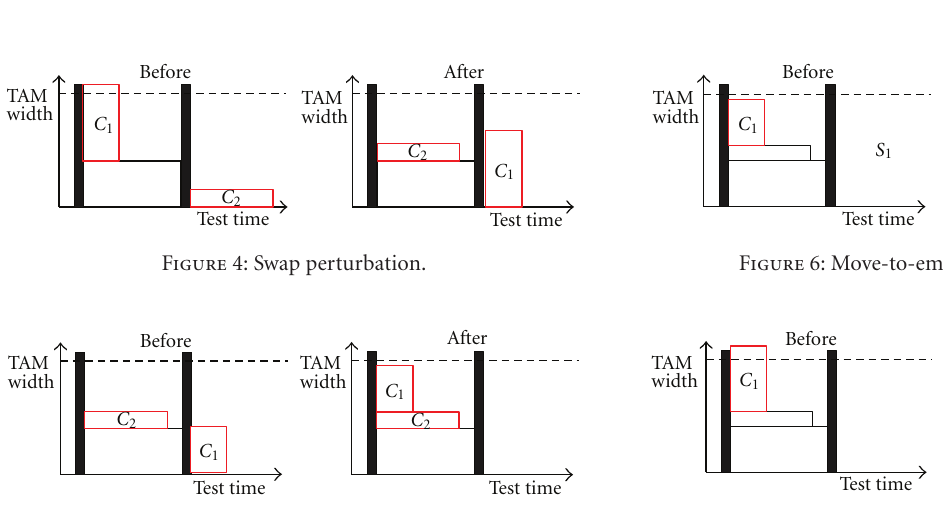
Figure 3: The overall flow.